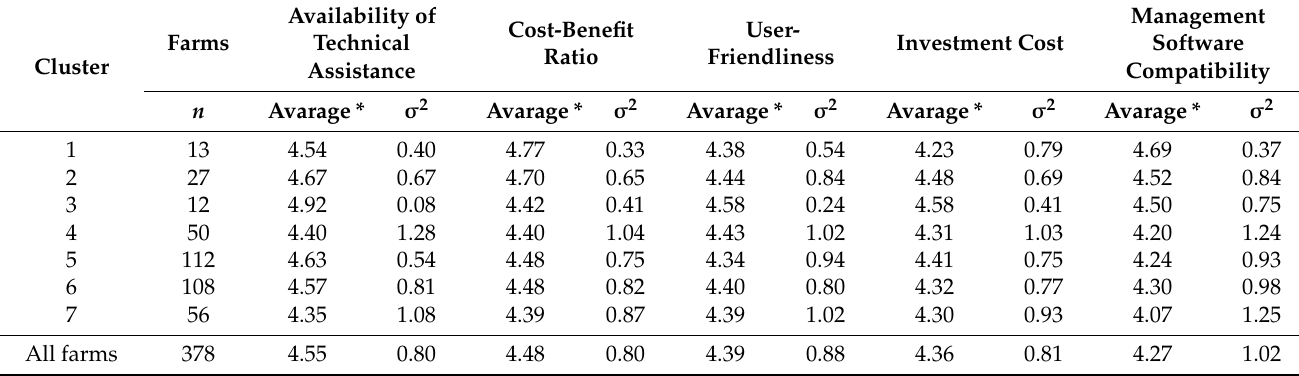
Table 6. Decision key criteria to purchase a precision technology.